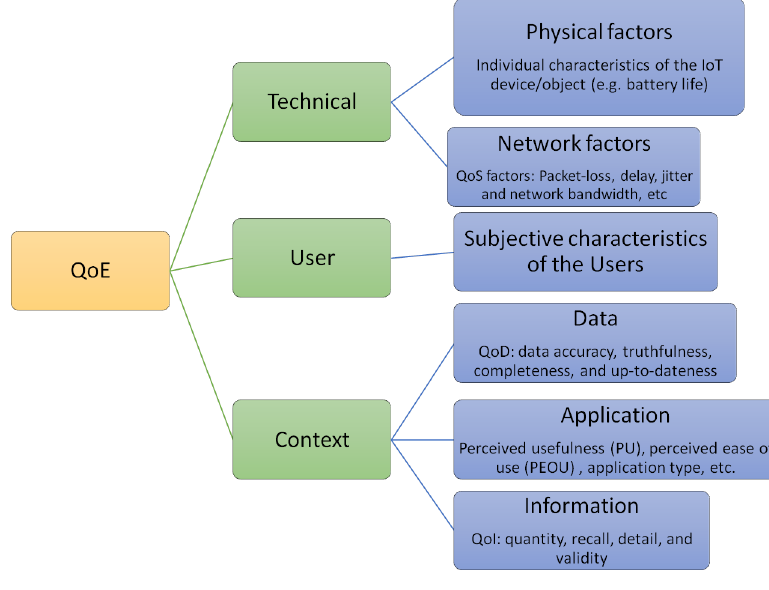
Figure 4. QoE taxonomy for IoT [7].